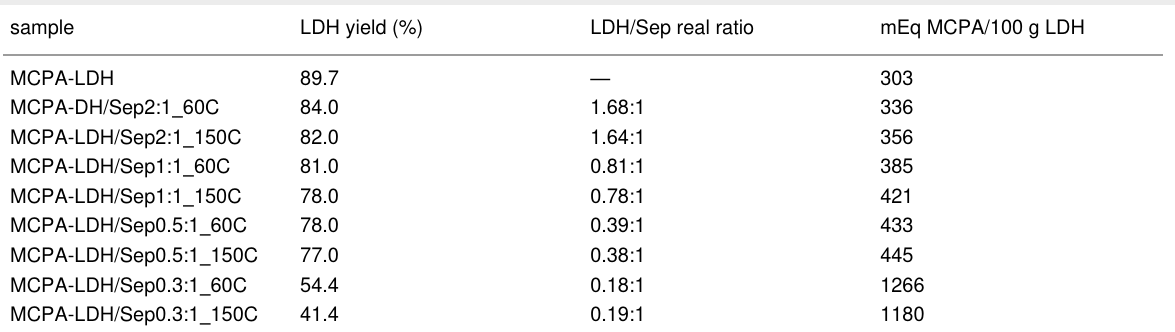
Table 2: LDH yield, LDH/Sep ratio and amount of MCPA incorporated in the hybrid nanoarchitectures prepared via coprecipitation. sample